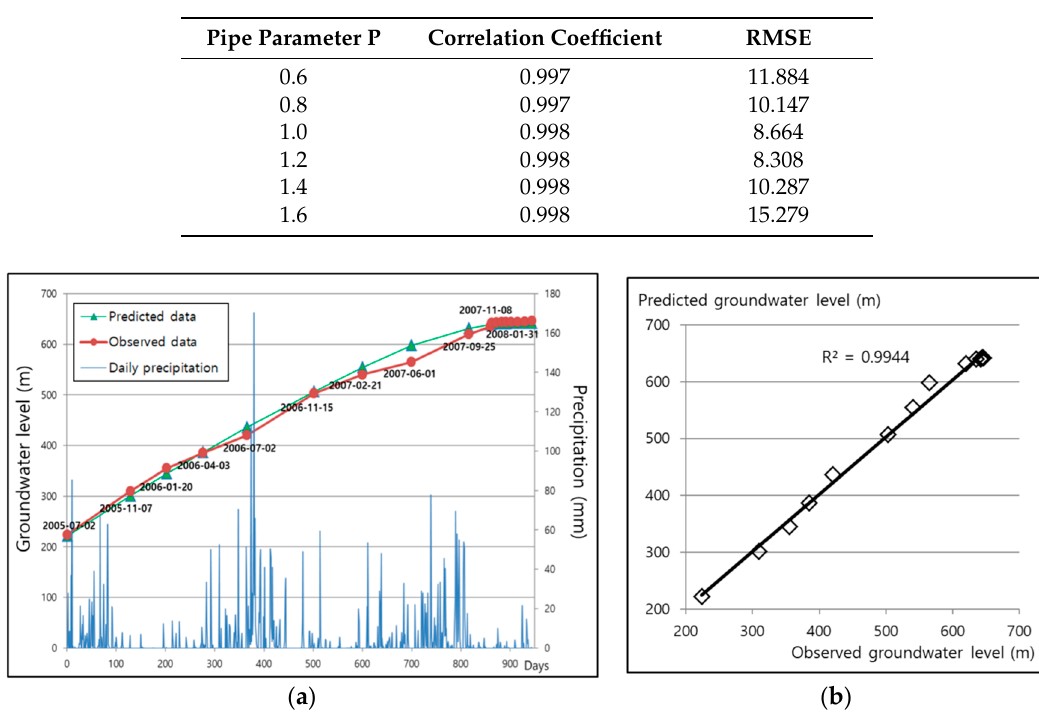
Figure 9. Results from the Dongwon coal mine. ( a ) Simulated and observed groundwater levels at the shaft; ( b ) Scatter plot of simulated and observed groundwater levels.